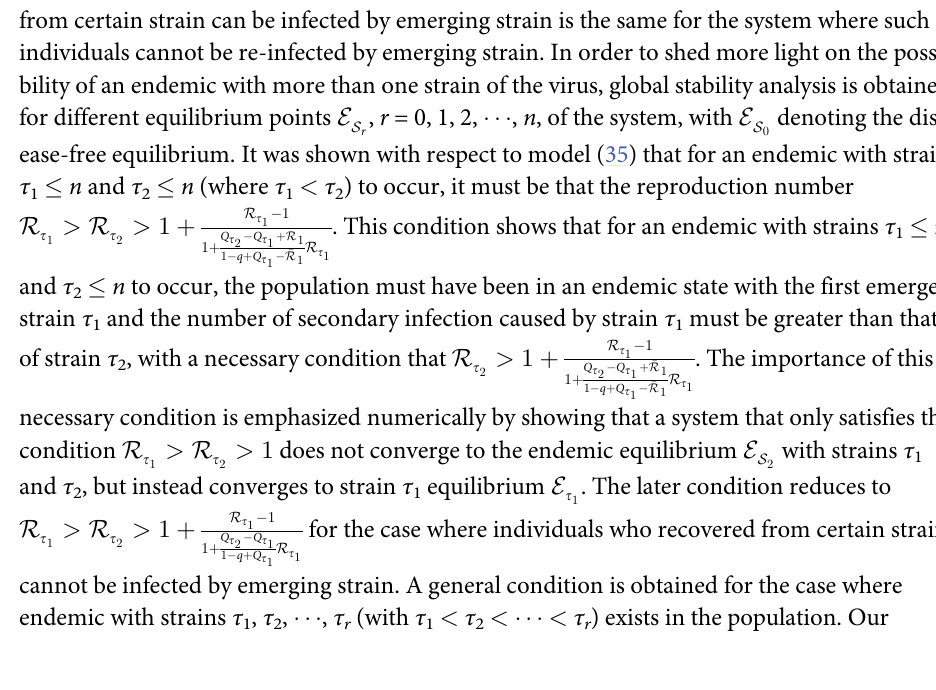
for the variant, using (14), was 0